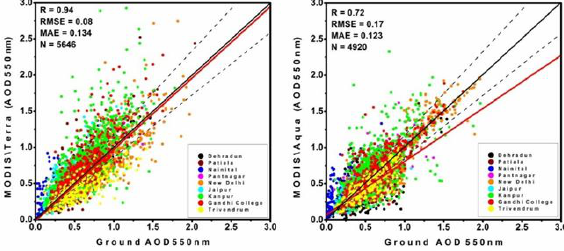
Figure 5. Scatter plots between MODIS 3-km AOD at 550nm (a) Terra and (b) Aqua against ground measured AOD for all locations across India during 2001- 2017. The red solid line represents ‘regression line’, the dash lines stand for the MODIS ‘Expected error lines’, and the black solid line is ‘1:1 line’. Overall, the correlation between in-situ and MODIS (Terra and Aqua) AODs are having strong correlation coefficient (R) as 0.94 and 0.72 with RMSE as 0.08 and 0.17 for Terra and Aqua respectively. The mean absolute error of overall daily AODs over Indian region is 13% for Terra and 12% for Aqua satellite (figure 5). Differences of statistical parameters found in